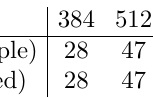
Table 12: Score of the best Type 2 trail found for number of rounds evaluated by the original submission document.